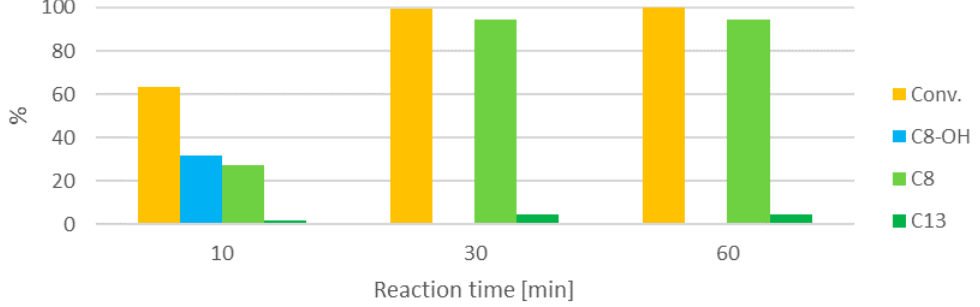
Figure 7. Influence of the reaction time (at 100 °C, furfural:HT 2:1, 0.21 M).